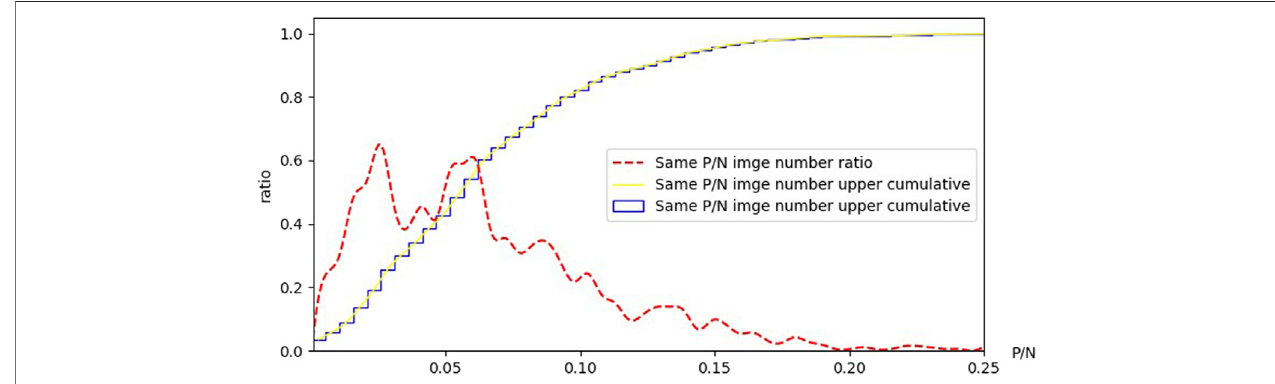
FIGURE 9 | Statistical histogram of positive and negative samples of dataset. In this study, a pixel from a droplet is called a positive sample, and a pixel from the background is called a negative sample. Same P/N means images have the same ratio of positive to negative samples.